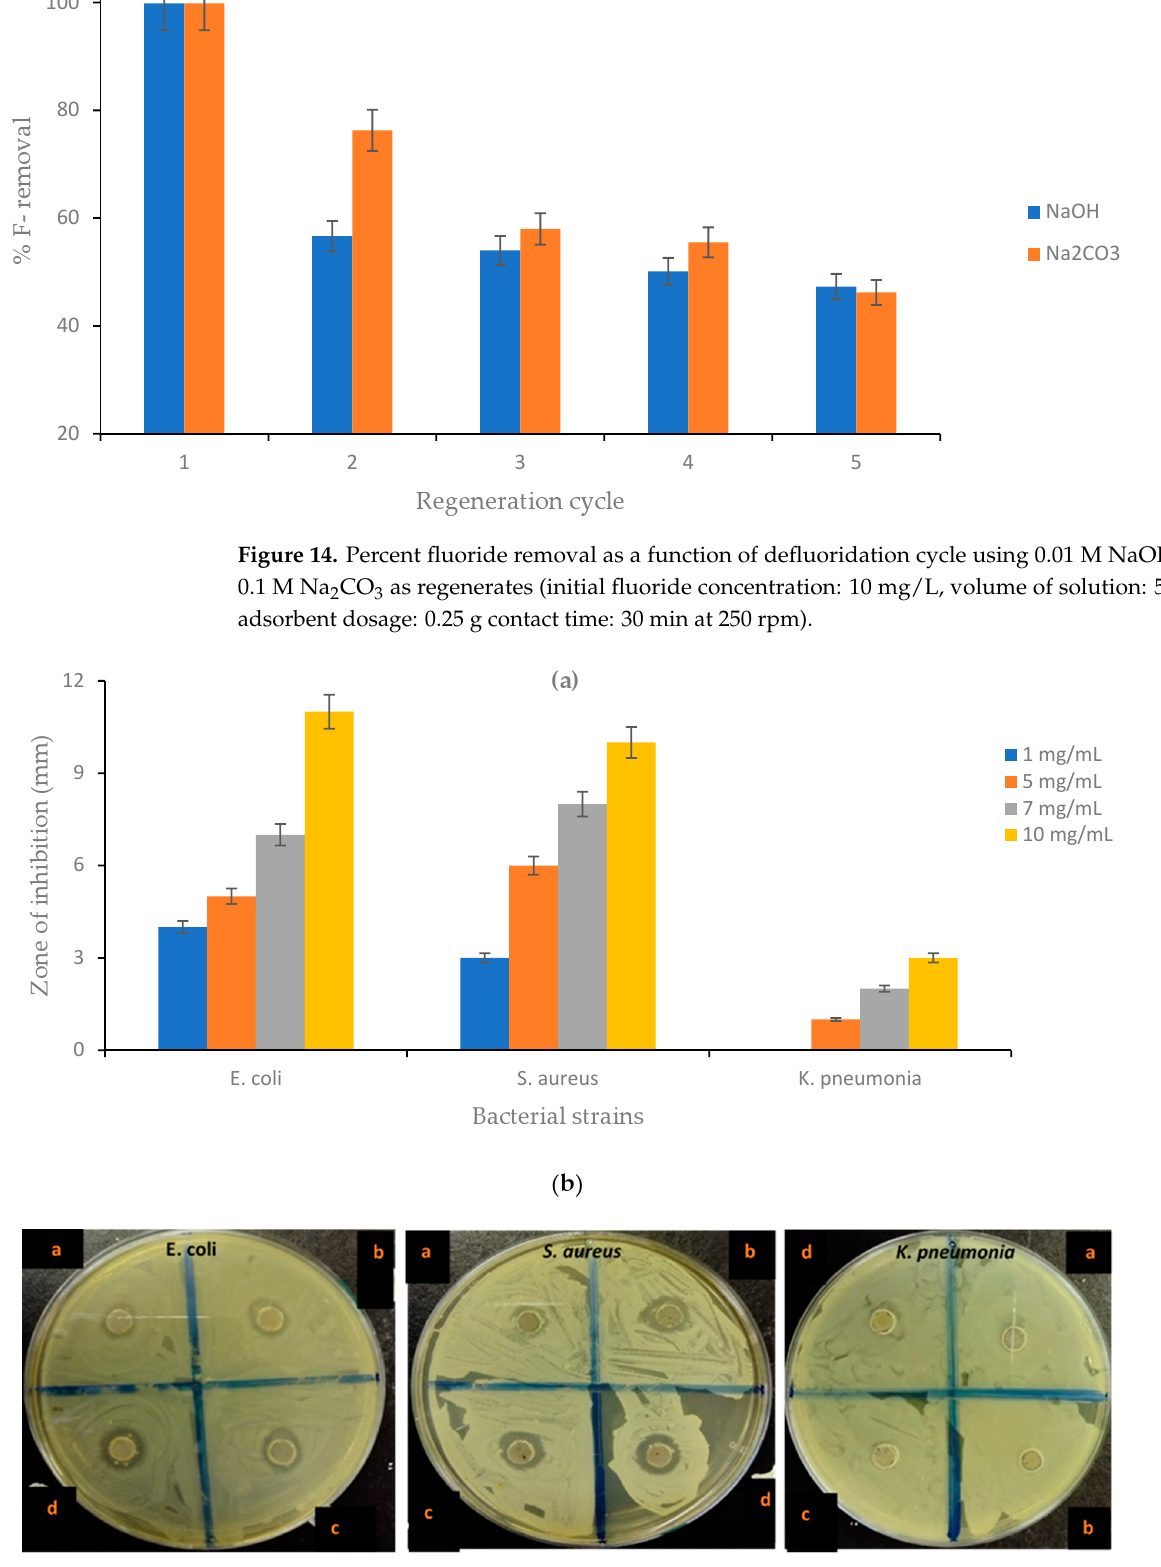
Figure 15. ( a ) Graphical representation and ( b ) photographic plate of antibacterial activity by the CNF-AgMgOnHaP composite against E. coli , S. aureus , and K. pneumonia at different concentration ranges.